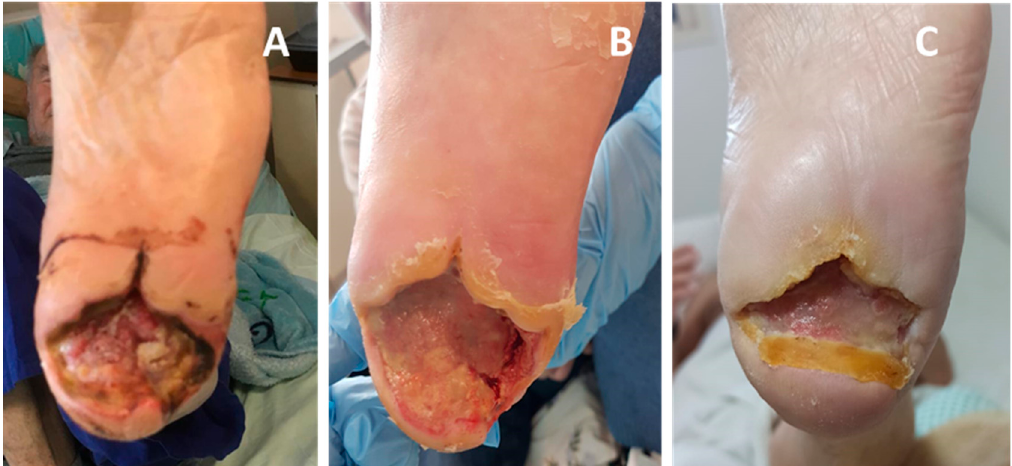
Figure 9. Exposed bone covered by granulation tissue in ischemic diabetic patient (Case Report 7). ( A ) Following angioplasty and surgical debridement, COD dressing was initiated. The dressing was replaced daily with a new COD. ( B ) Eighteen days following COD treatment, the exposed bone was covered by new tissue. ( C ) Three months following COD treatment, the wound was significantly smaller.